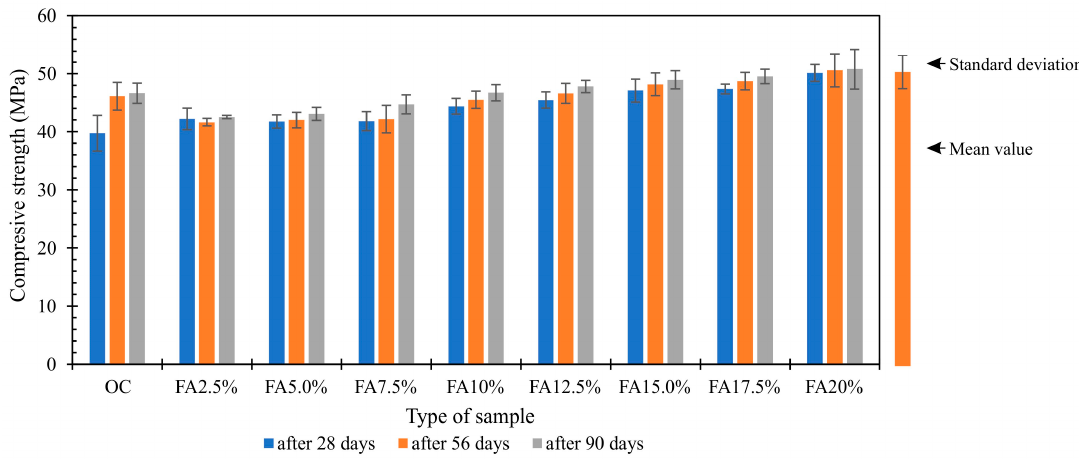
Figure 7. Compressive strength after 28, 56 and 90 days of maturation.